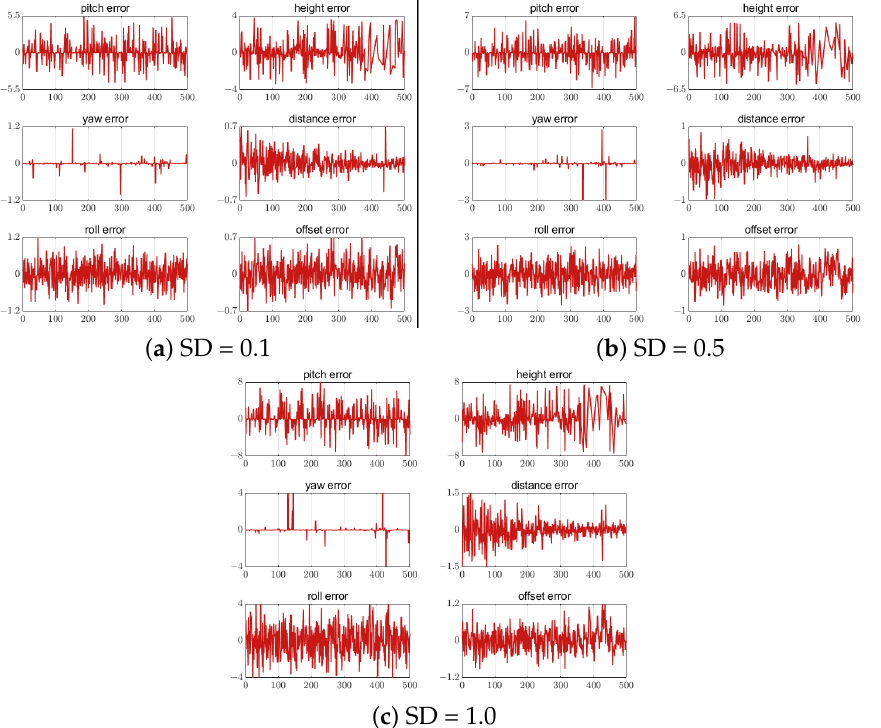
Figure 24. Error of 9 feature points with different SD. The unit of the attitude error is degree. The unit of the position error is meter. The horizontal axis in all figures is the number of measurement points.